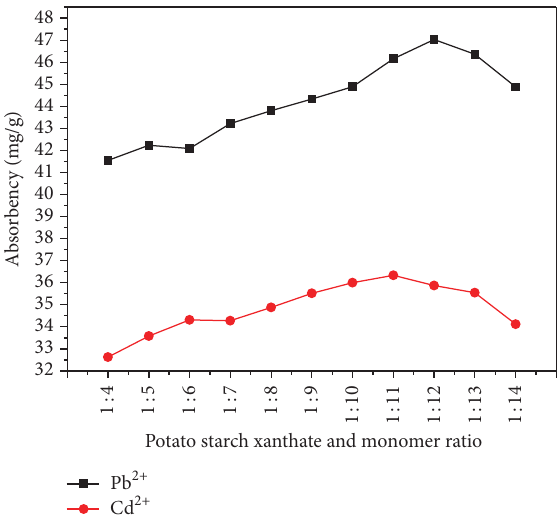
Figure 3: Dosage of cross-linker on polymer adsorbed Pb 2+ and Cd 2+